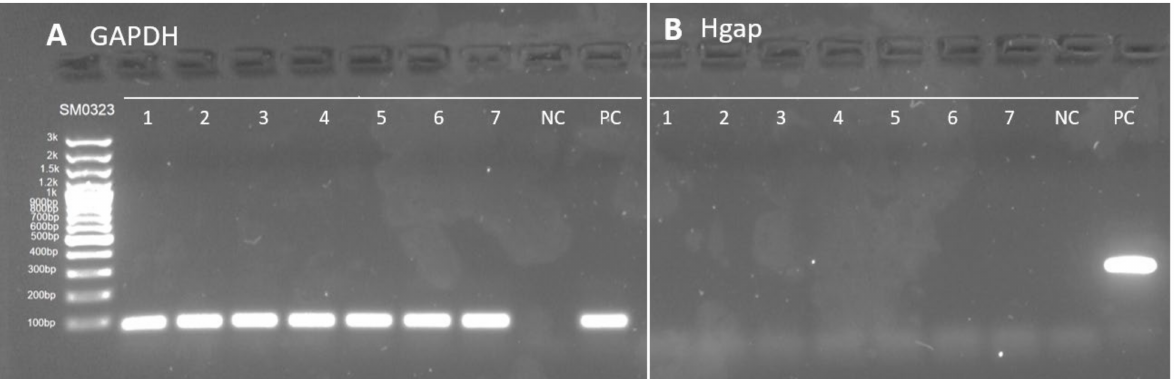
Figure 1. Representative results of conventional (c)PCR testing of DNA extracted from liver biopsies from dogs with canine idiopathic chronic hepatitis or hepatocellular carcinoma. Samples 1 to 7 all tested ( A ) positive for GAPDH and ( B ) negative for domestic cat hepadnavirus. All 101 samples tested negative on 3 cPCRs for hepadnavirus DNA. NC = negative control, PC = positive